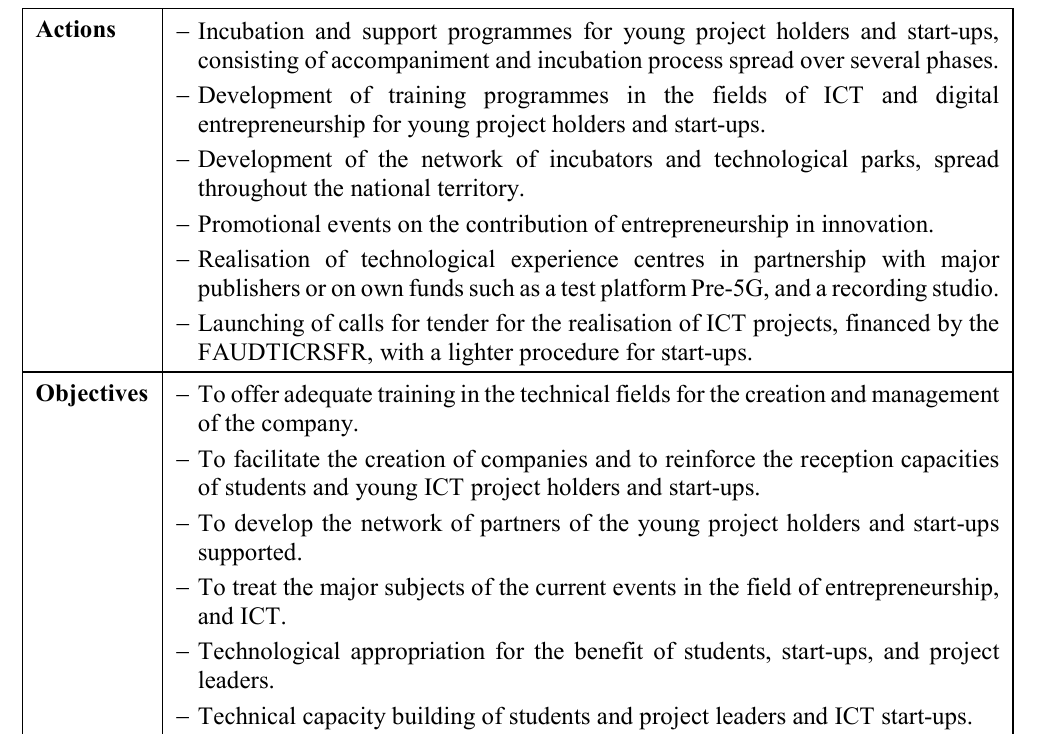
Table 1. Objectives, Actions and Results of the Year